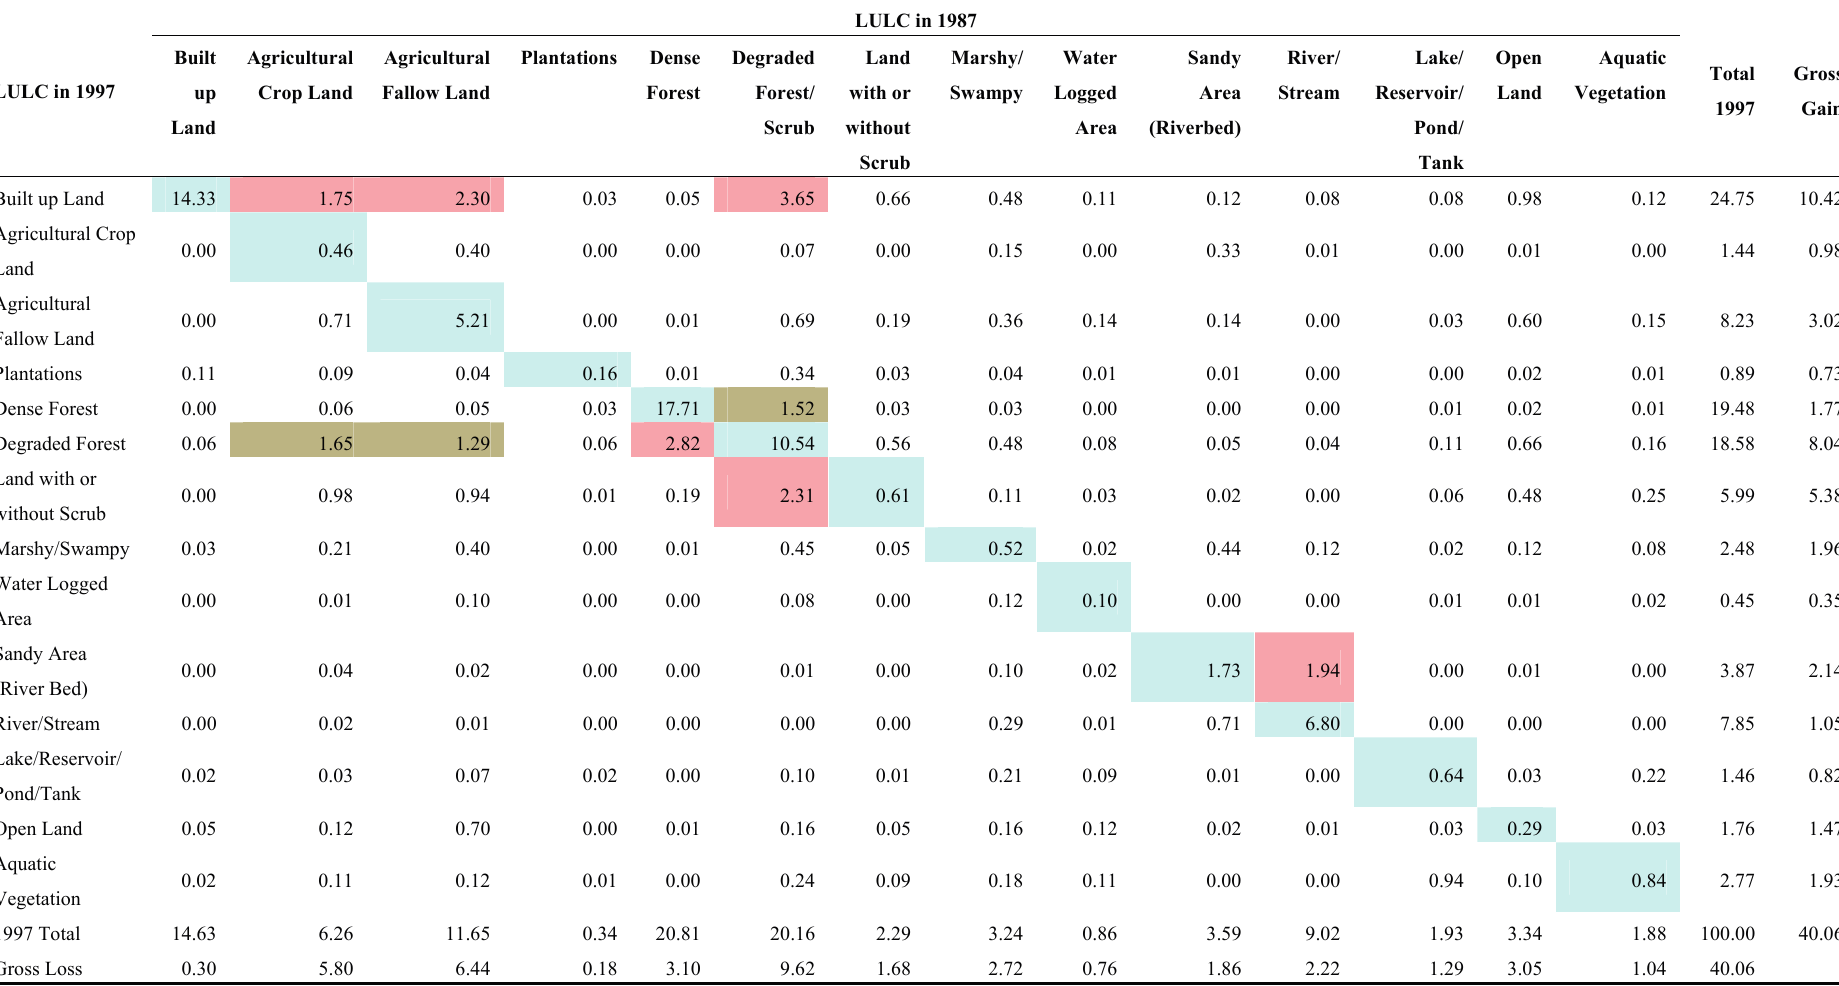
Table 7. Losses and gains, respectively. Light sky shows persistence 1 of categories 2, while pink and ash colors show major changes (in between